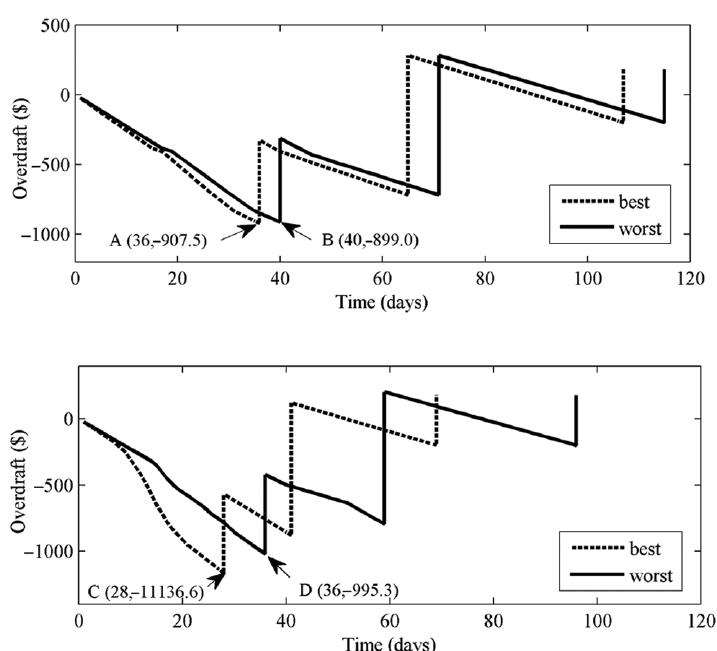
Fig. 18. Project overdraft at possibility level 0 without task overlaps (top) and with task overlaps